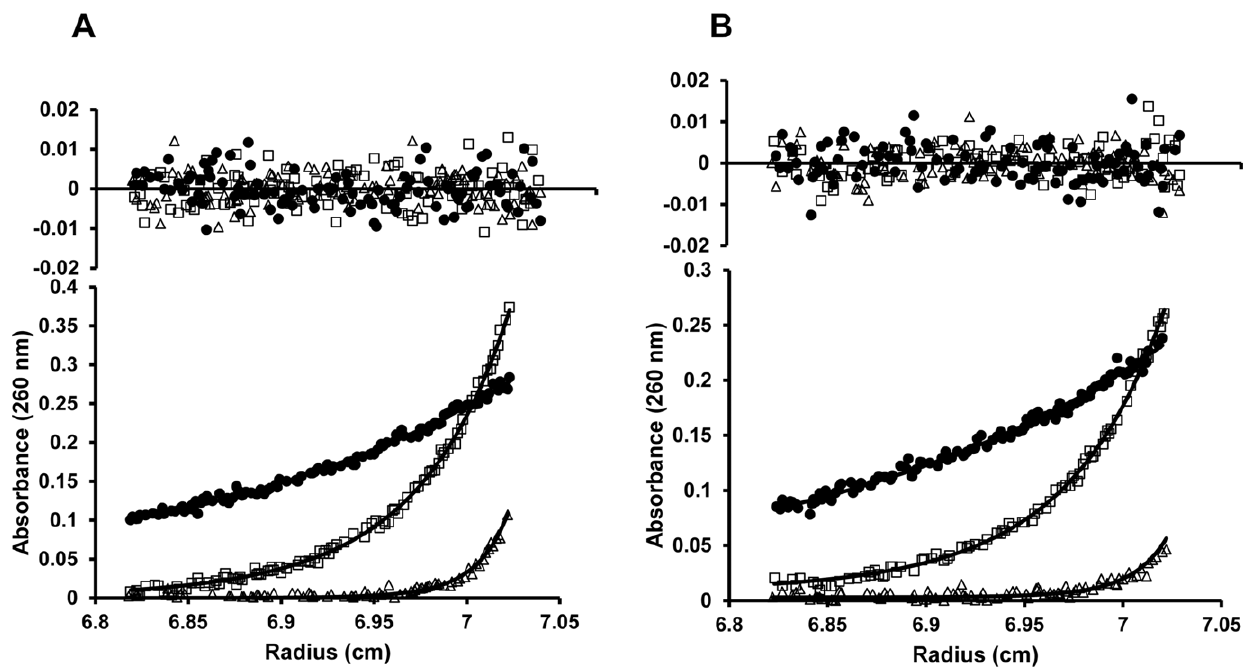
N ), 19,800 ( % ) and 34,000 ( D ) rpm. The K d s obtained for